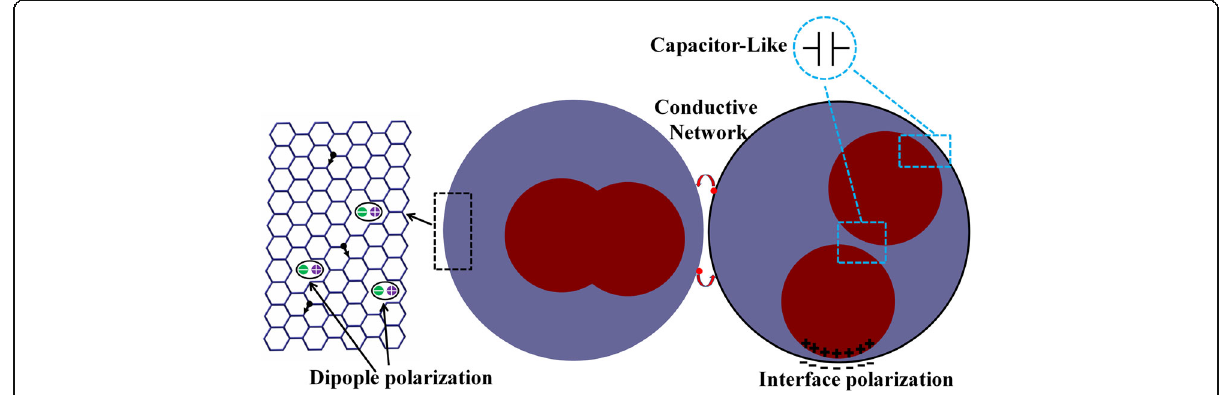
Fig. 8 Schematic illustration for the microwave absorption mechanism of